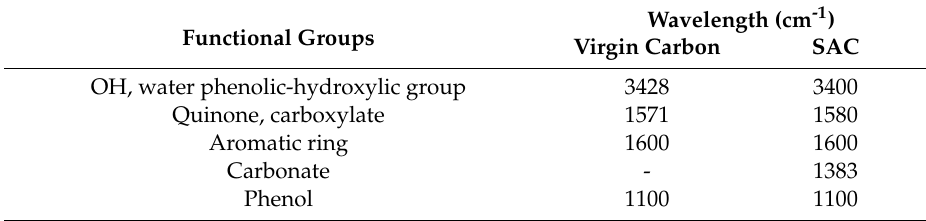
Figure A4. FTIR spectrum of virgin carbon and SAC. Table A3. Interpretation of the FTIR spectrum of virgin carbon and SAC.